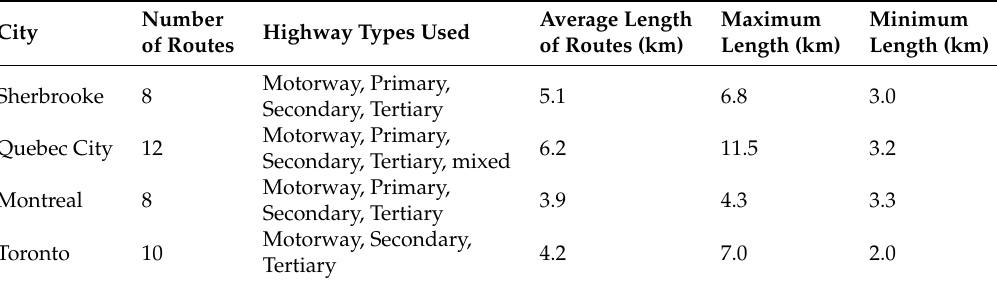
Figure 13. Route travel time on Aut. Décarie, Montreal (north direction) (Road type: motorway, route length: 3.83 km). Table 3. Statistics of the routes